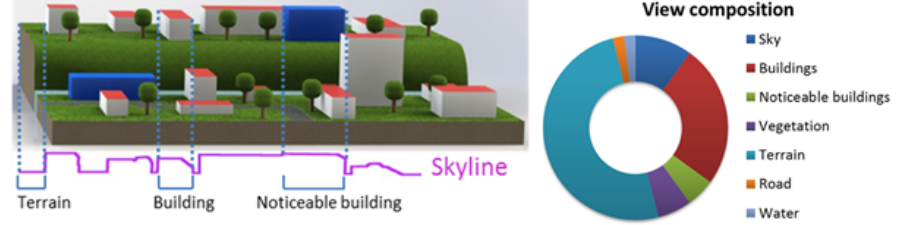
Figure 10. View composition analysis. ( Left ): decomposition of the skyline according to the inter- sected object. ( Right ): the view